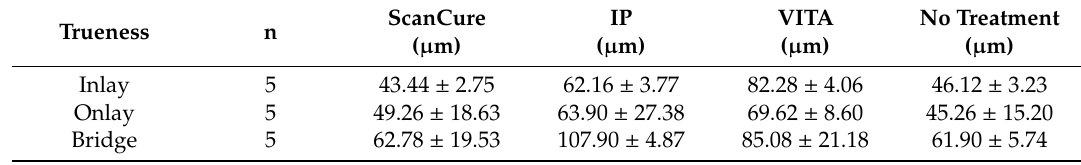
Table 2. Mean trueness value according to an intraoral scanner (mean ± SD of RMS)